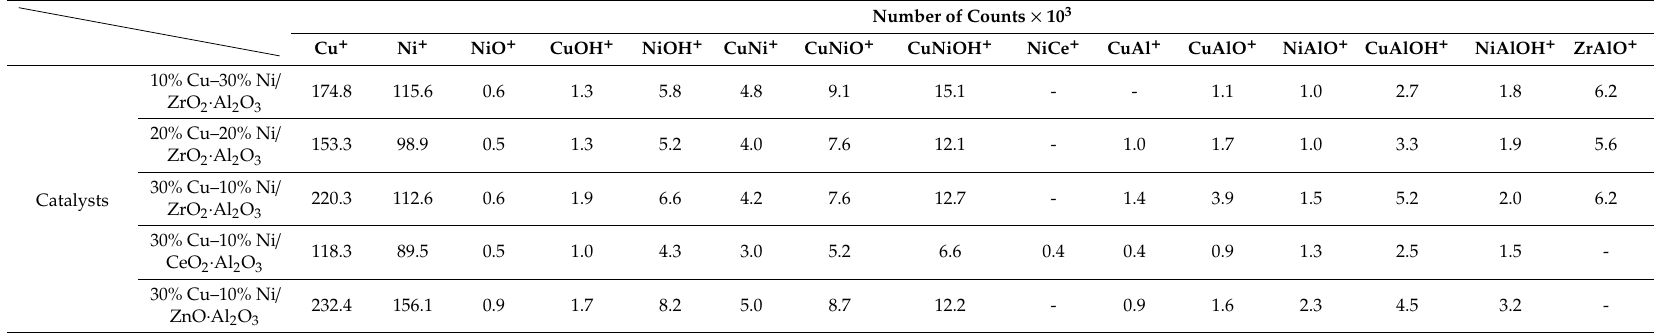
Table 4. The intensity of the selected secondary ions identified on the surface of the investigated bimetallic catalysts reduced in a mixture of 5% H 2 –95% Ar at 300 ◦ C for 1